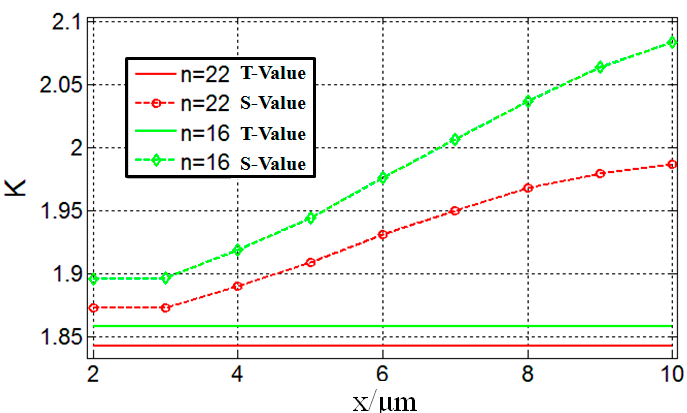
Figure 3. Evolution of the kurtosis for two different flat top SPP beams as a function of the propagation distances. w o = 1.22 λ spp , N = 22 (red curves) and N = 16 (green curves). The solid curves represent the theoretical values (T-Values) obtained by Equations (2) and (3), for N = 22, K = 1.8422 (red solid curve), for N = 16, K = 1.8579 (green solid curve). The dotted curves represent the simulation values (S-Values) obtained by FDTD software.